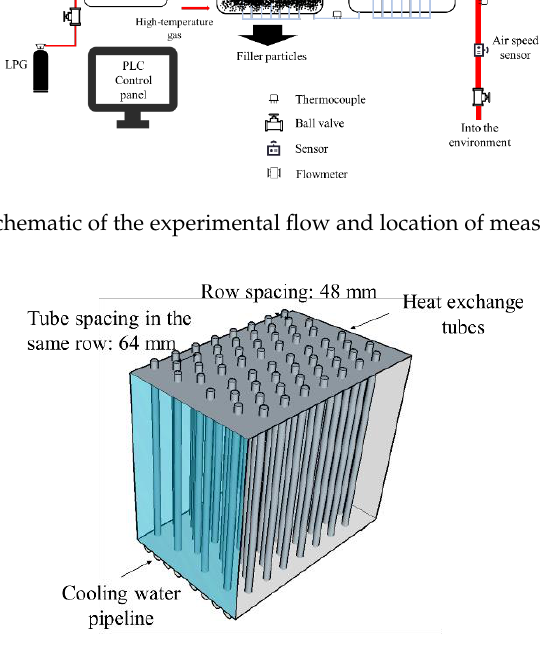
Figure 2. Schematic of the arrangement of heat exchange tubes.